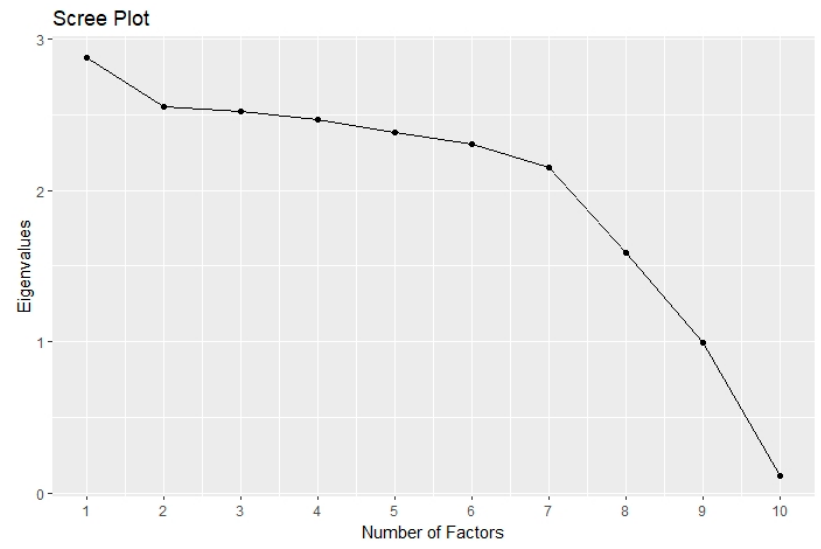
Figure 1. Scree plot